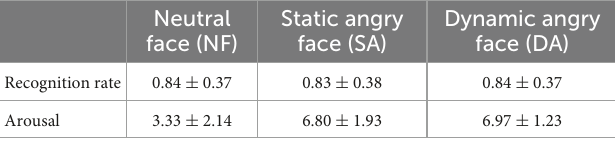
TABLE 1 Description of ratings of different facial stimuli ( M ± SD